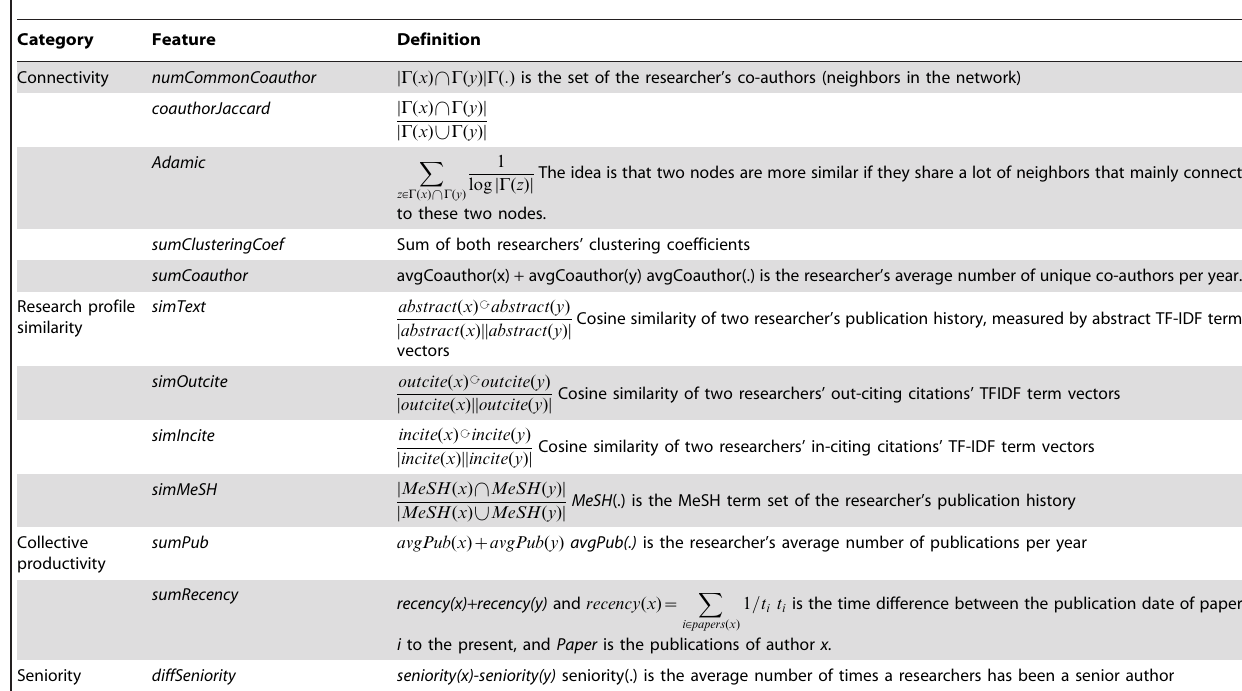
Table 1. Feature definition.